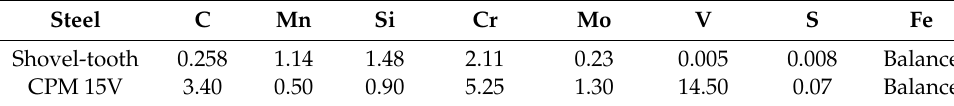
Table 1. Chemical compositions (wt%) of the steels joined by